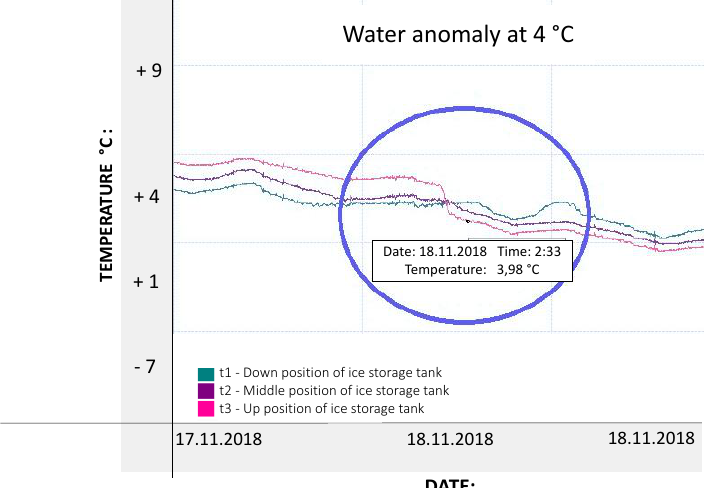
Figure 17. II. Phase—Inverse waster stratification.